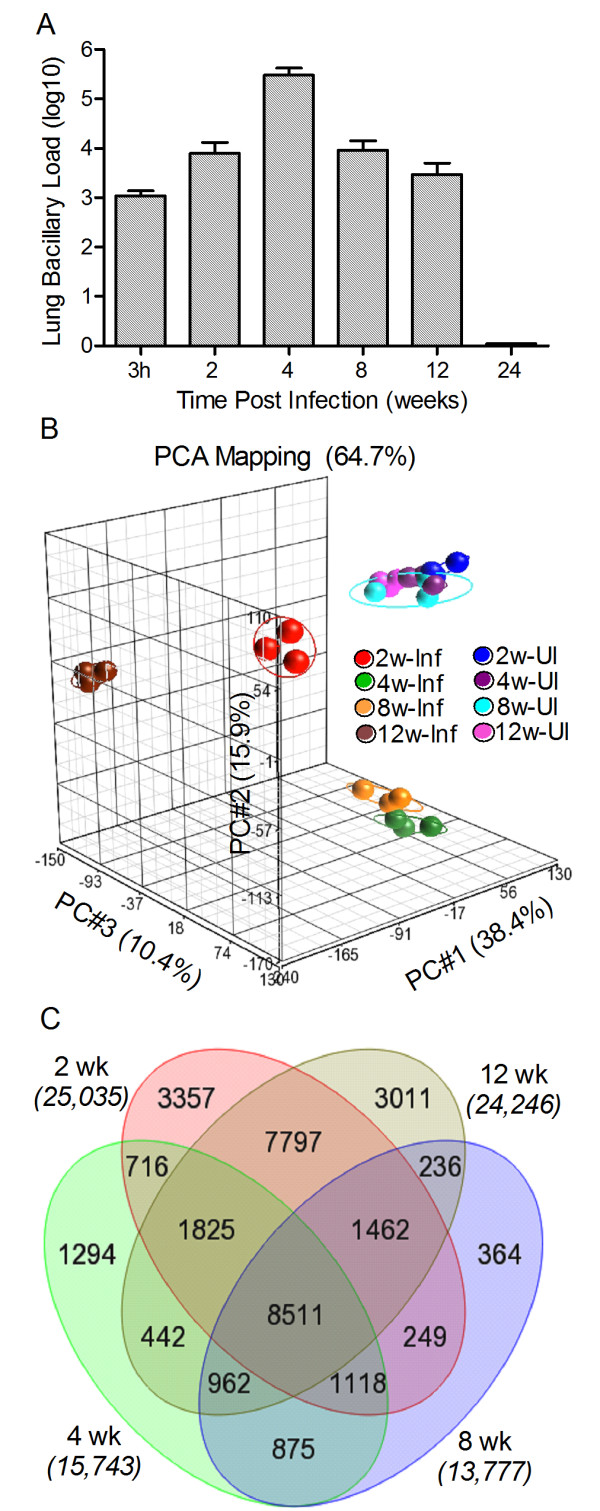
Bacillary growth and global transcriptome analysis of rabbit lungs during Mtb CDC1551 infection. Bacterial CFU in the lungs were enumerated up to 24 weeks and microarray analysis of gene expression profile was performed in the lungs of Mtb-infected rabbits at 2, 4, 8 and 12 weeks post-infection and compared to the uninfected animals. A: Total lung bacillary load determined by plating organ homogenates from each infected rabbit on agar plates. For each animal, about 30% of the entire lung, comprising all 5 lung lobes, was used to prepare the homogenates. B: PCA mapping of data points obtained from pooled samples from uninfected (n = 3) or one experiment from each of the three biological replicates from Mtb-infected rabbit lungs at each time point (n = 3 per time point). Eclipse drawn around the triplicate data points for each time point represents area spanning two-fold standard deviation from the median expression levels. C: Venn diagram showing the number of statistically significantly differentially expressed genes (SDEG) by Mtb infection of rabbit lungs at 2, 4, 8 and 12 weeks post-infection. The genes were selected based on a False Discovery Rate (FDR) of 5% (equivalent to p ≤0.05).